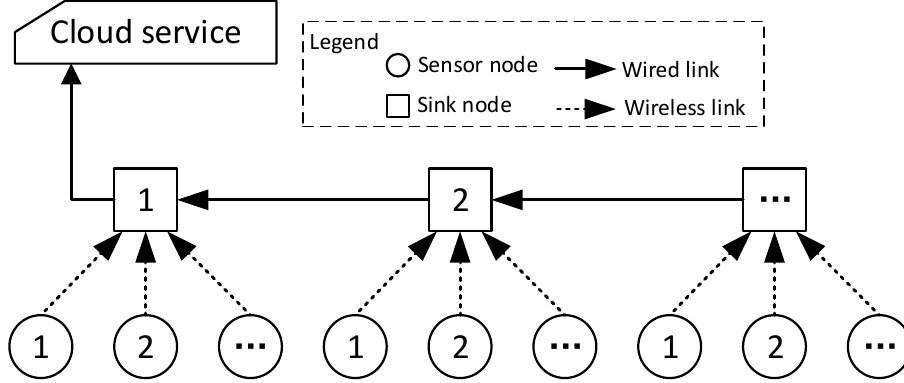
Figure 1. Data transmission model of Internet of Things (IoT) in underground